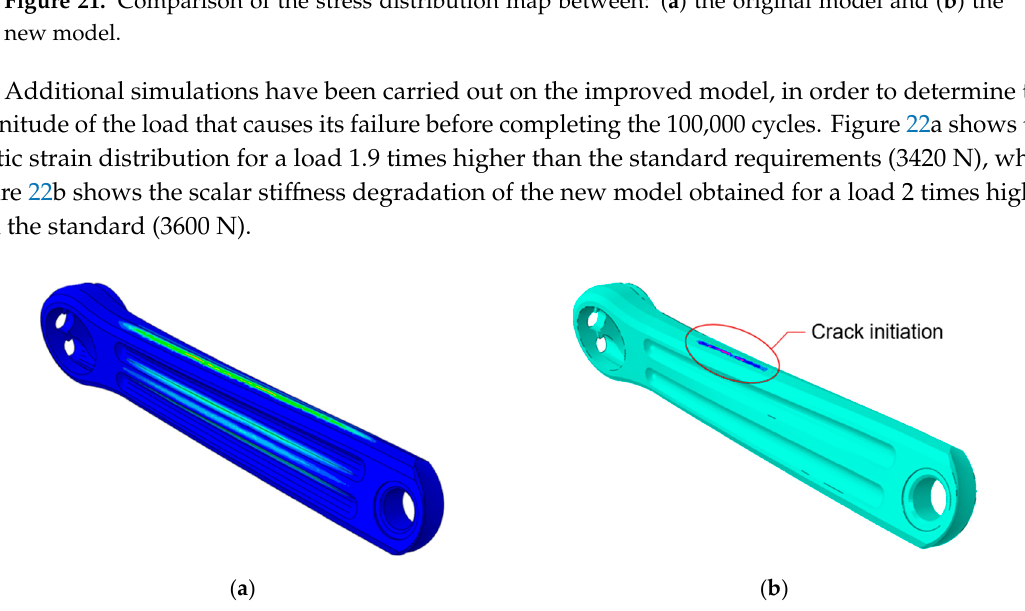
Figure 22. ( a ) Permanent deformation and ( b ) scalar stiffness degradation of the new crank arm model.